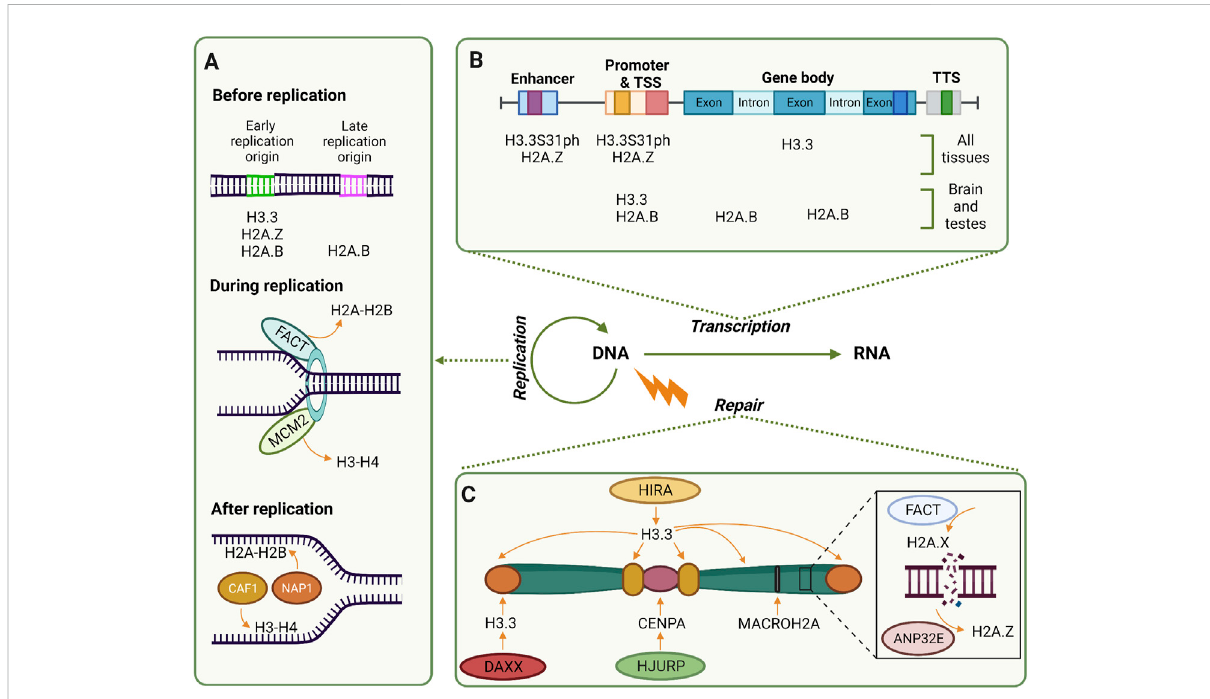
FIGURE 1 Histone variants are largely involved in replication, transcription, and replication . (A) Before replication, early replication origins are enriched in H3.3 and H2A.Z in the majority of the cells, while H2A.B is in both early and late replication origins in the brain and testes. During replication, chaperones FACT and MCM2 remove histones to have naked DNA ready. Right after replication, chaperones CAF1 and NAP1 deposit replication dependent H3-H4 and H2A-H2B respectively. (B) Transcription active genes are enriched with different histone variants. While H3.3 and H2A.Z are enriched at enhancers and promoters, H3.3 is also present at gene bodies. H2A.B is present at promoters and intron-exon boundaries of active genes of the brain and testes. (C) Along the chromosome, distinct variants are deposited by distinct chaperones depending on the regions and